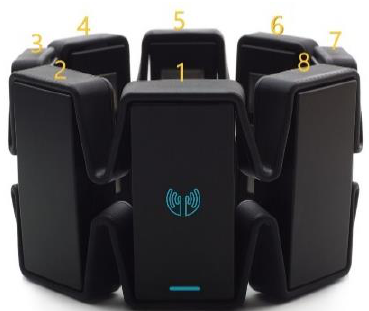
Figure 1. The armband for data acquisition.